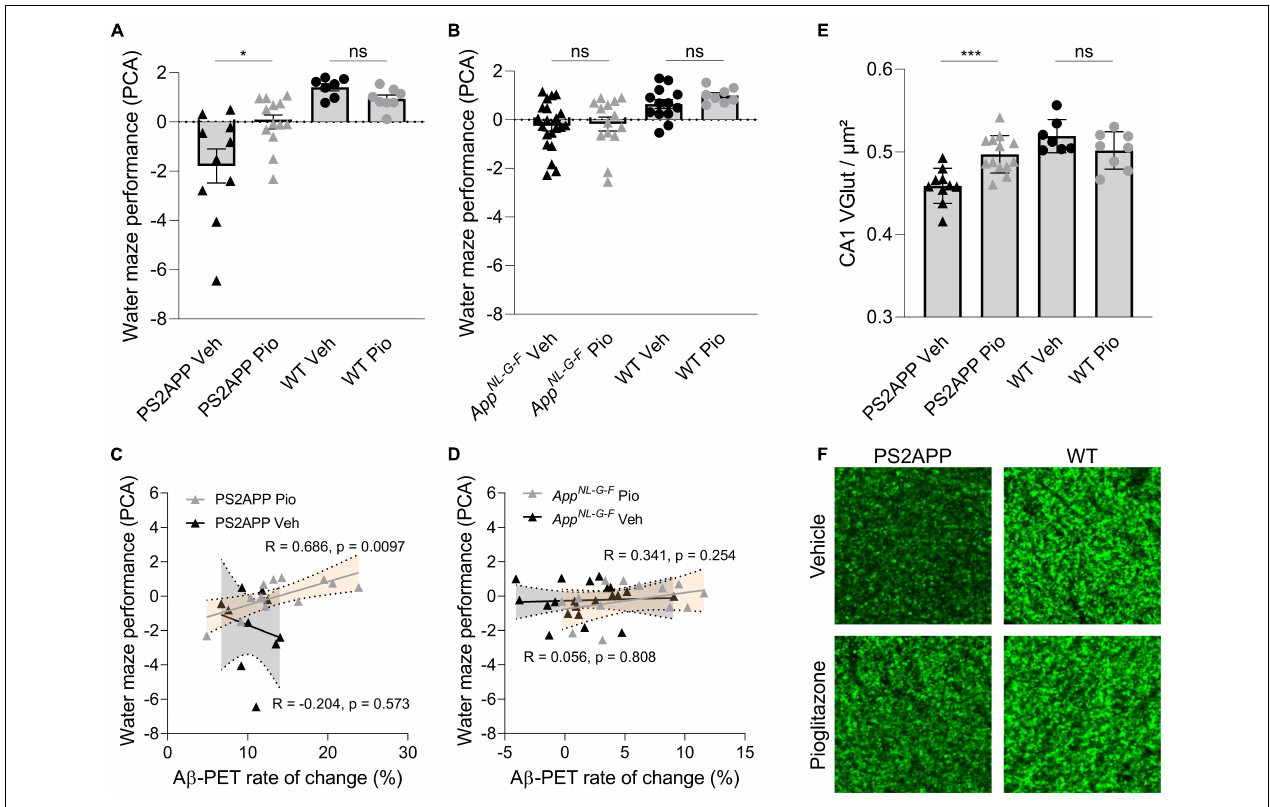
FIGURE 5 | Improved spatial learning correlates with an increased A β -PET rate of change in PS2APP mice. (A) One-way ANOVA revealed a significant difference of the water maze performance index between pioglitazone treated and untreated PS2APP and wild-type groups [ F ( 3 , 34 ) = 10.37; p < 0.0001; N = 7–13]. Group-wise comparisons revealed that pioglitazone treated PS2APP mice achieved a higher performance index in the water maze test compared to untreated PS2APP mice ( p = 0.016), whereas wild-type animals showed no significant difference between treatment groups ( p > 0.999). (B) One-way ANOVA revealed a significant difference of the water maze performance index between pioglitazone treated and untreated App NL - G - F and WT groups [ F ( 3 , 34 ) = 5.825; p = 0.0016]. However, pioglitazone treated App NL - G - F mice showed no difference in the water maze performance index when compared to untreated App NL - G - F mice ( p > 0.999) and wild-type animals again showed no significant difference between treatment groups ( p > 0.999). Scatter plots show correlations between the A β -PET rate of change ([ 18 F]florbetaben; (cid:49) SUVR) during the treatment period and individual cognitive testing scores in (C) PS2APP mice and in (D) App NL - G - F mice (R indicates Pearson’s coefficient of correlation) (E) The decrease in synaptic density in the hippocampal CA1-region as assessed by VGLUT1 staining was ameliorated in treated PS2APP mice when compared to untreated mice ( p = 0.0012), whereas no such treatment effect was seen in wild-type animals [ p = 0.810; group effect: F ( 3 , 34 ) = 12.03; p < 0.0001; N = 7–13]. (F) VGLUT1 staining in the hippocampal CA1-region of representative untreated and treated PS2APP mice (left column) as well as of representative untreated and treated wild-type (WT) mice (right column). Statistics of group wise comparisons derive from one-way ANOVA with Bonferroni post-hoc correction: * p < 0.05; *** p < 0.005. Data are presented as mean ±